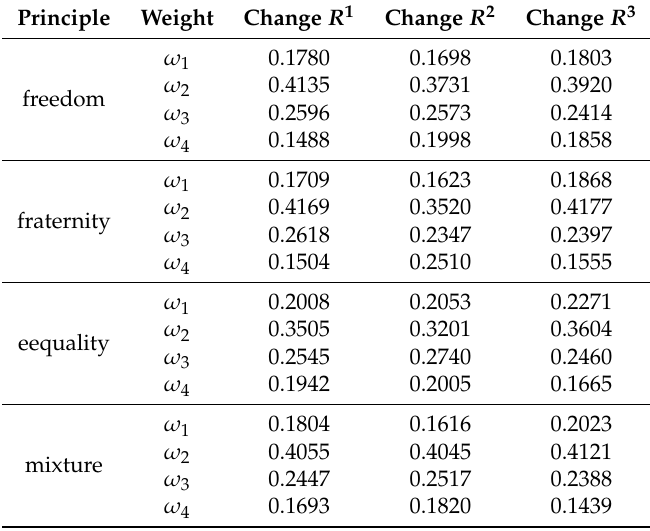
Table 3. Priorities determined using the modified matrices and I -consistency.